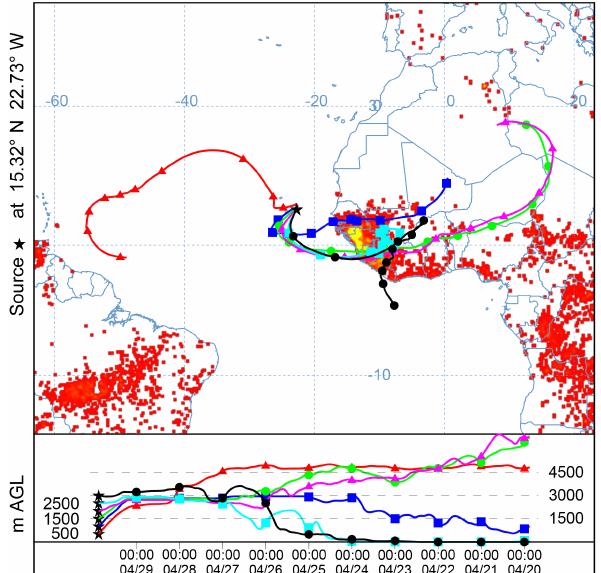
Figure 12. NOAA HYSPLIT backward trajectories ending at 29 April 2016 21:00UTC at the position of RV Polarstern (15.32 ◦ N, 22.73 ◦ W; marked by the black star) at different alti- tudes. Additionally, fires detected by MODIS on-board the Terra and Aqua satellites are shown. Fires are accumulated over the 10- day period from 20 to 29 April 2016. Yellow colour indicates a large number of fires, and red dots indicate a low number of fires in the considered period (https://lance.modaps.eosdis.nasa.gov/firemaps, accessed: 24 February